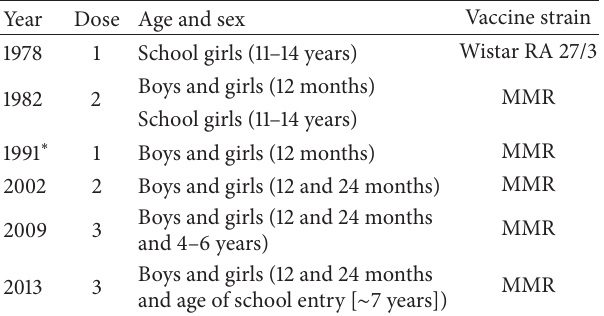
Table 1: Summary of the history of the implemented rubella vaccination programs in Saudi